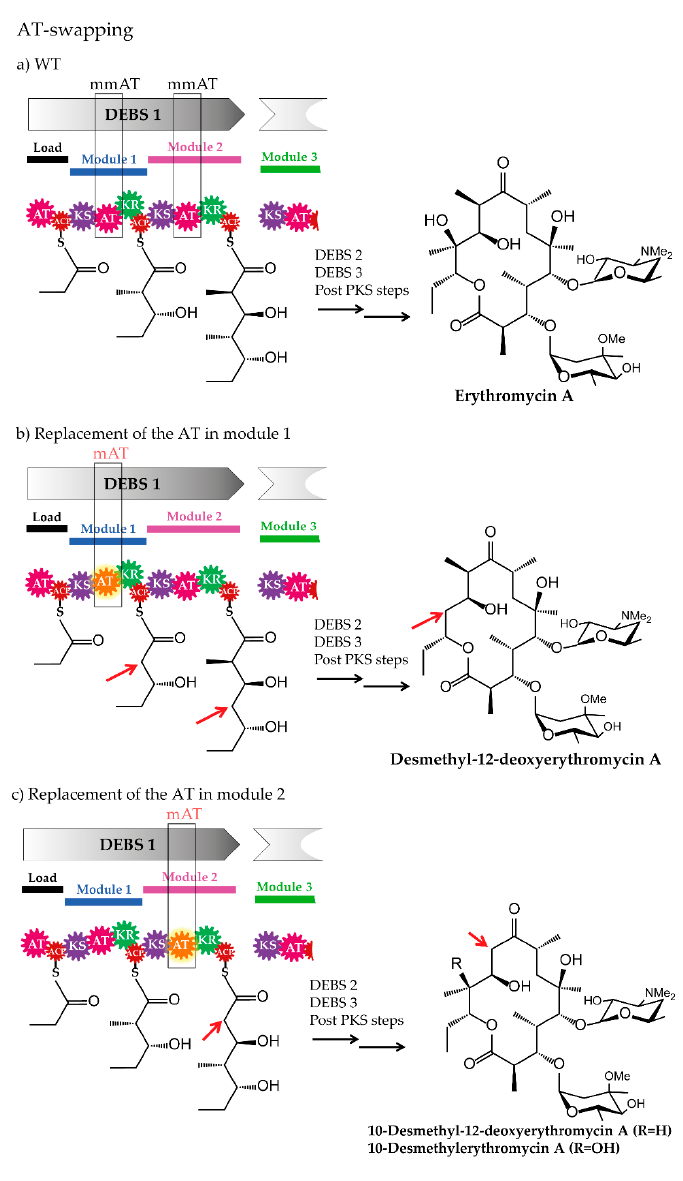
Figure 4. Examples of AT swapping [50]. ( a ) Part of the erythromycin assembly line illustrating DEBS 1 and the final structure of erythromycin A, produced by the wild type strain Saccharopolyspora erythraea ER720. ( b ) Mutant in which the AT domain of module 1 was replaced by a malonyl-CoA specific AT (loading malonate onto the ACP). The mutant strain produced the derivative 12- Desmethyl-12-deoxyerythromycin A. ( c ) Mutant in which the AT domain of module 2 was replaced by a malonyl-CoA specific AT (loading malonate onto the ACP). The mutant produced the derivatives 10-desmethyl-12-deoxyerythromycin A and 10-desmethylerythromycin A. Abbreviations: AT, acyltransferase; ACP, acyl carrier protein; KS, ketosynthase; KR, ketoreductase; mmAT: AT loading methylmalonate; mAT: AT loading malonate.